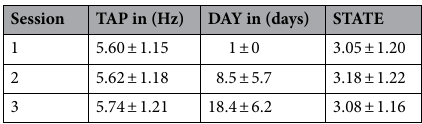
Table 3. TAP, DAY, and STATE on the three session.